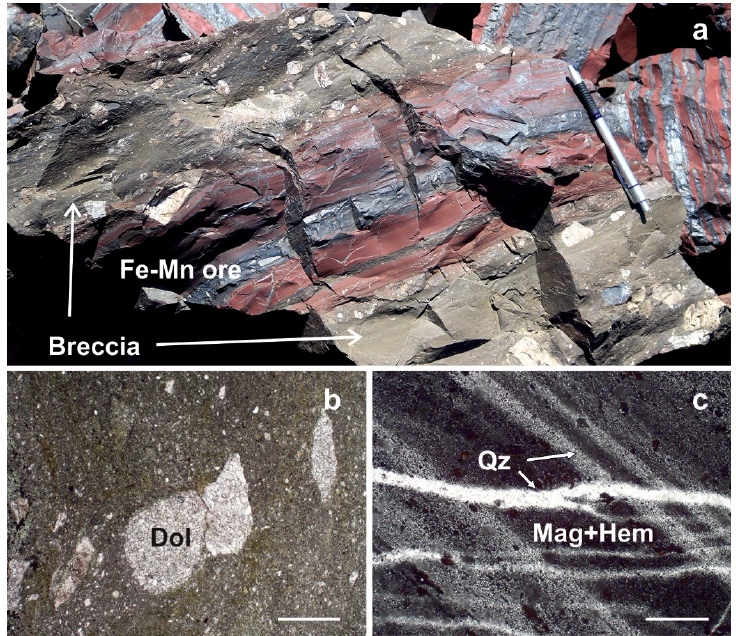
Figure 2. Iron-manganese ore at the Poperechnoye deposit associated with volcanic explosive breccia: ( a ) field photograph, thin section microphotographs of explosive breccia ( b ) and iron-oxide ore ( c ). Scale in photos b and c is 40 µm.